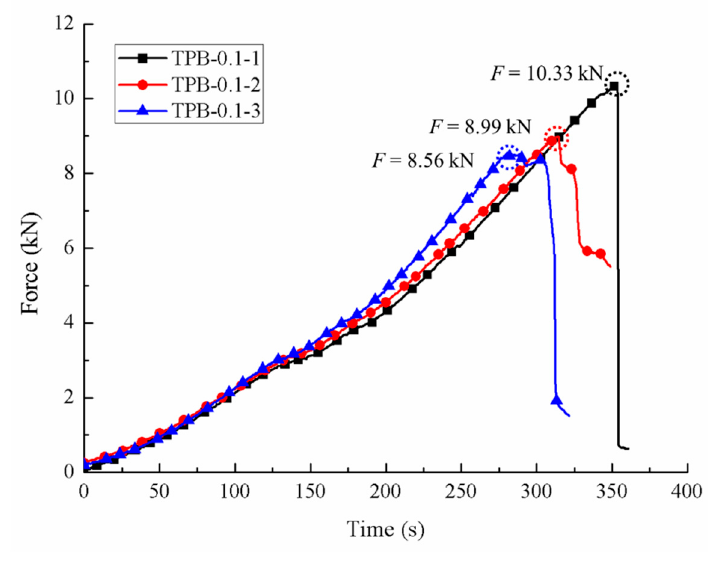
Figure 4. Force-time curves under the static loading conditions.